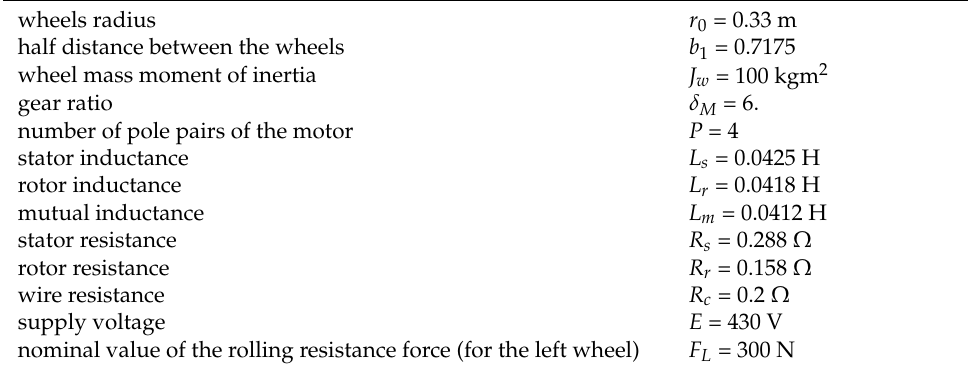
Table A1. Constant parameters of the wheelchair control system